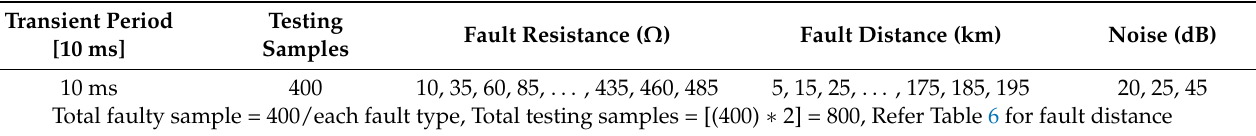
Table 7. Testing fault scenarios for testing data.